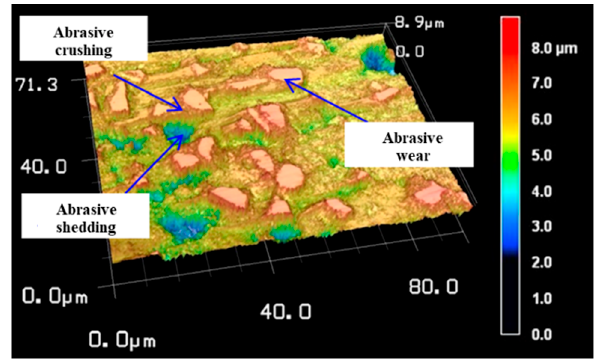
Figure 2. Microscopic wear of a silicon carbide grinding wheel.